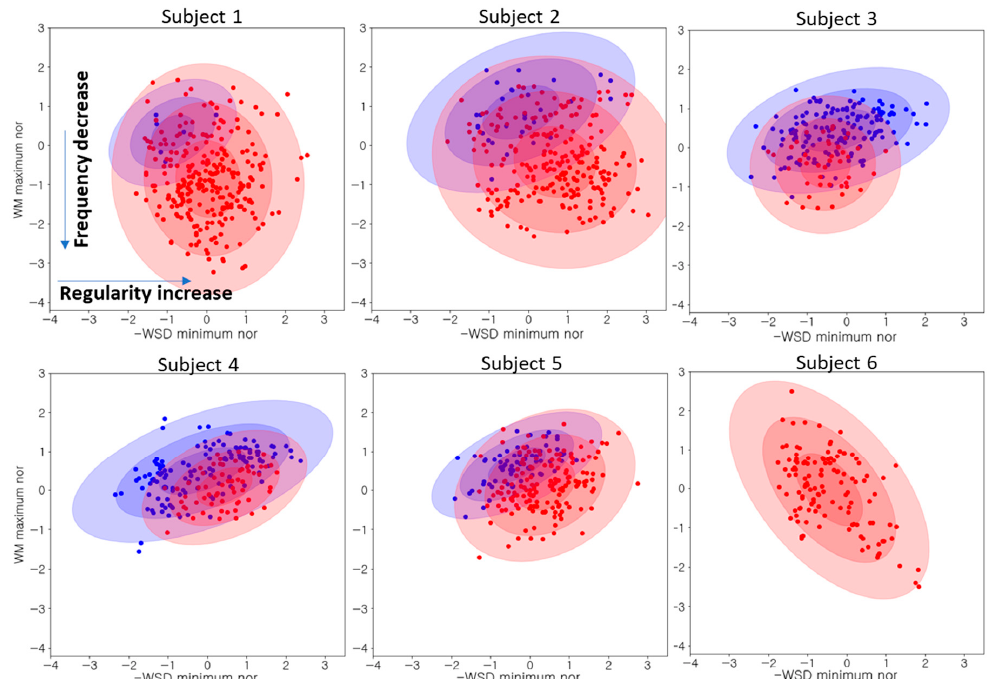
Figure 4. Scatterplots of the proposed features for each subject in our dataset. Here, blue dots represent wake epochs, and red dots represent drowsy epochs. The X-axis represents minus the weighted standard deviation (WSD), and the Y-axis represents the weighted mean (WM). The colored circles are the Gaussian distribution fitted for each label (i.e., drowsy or wake states).